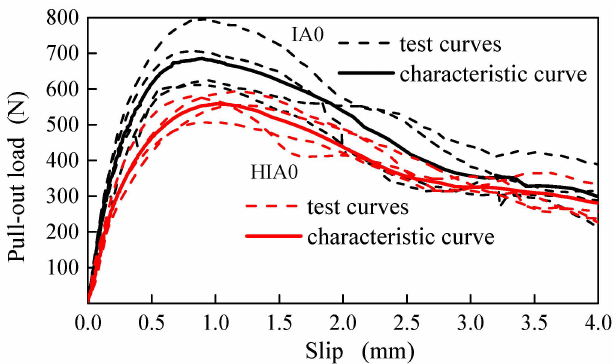
Figure 2. Two characteristic PL-S curves from the test curves of two groups of specimens. Accompanied with each series of specimens, three mortar prisms with dimension of 40 mm × 40 mm × 160 mm were poured for determining its flexural and compressive strengths as per China code GB/T17671 [35]. Due to the difference of casting time and environment, a differential of strength exists in different series of specimens, even though they all have the same composition and test age. The compressive and flexural strengths of mortar used for Series IA, HIA and NA were 75.8 MPa and 11.13 MPa, 69.9 MPa and 8.35 MPa, 77.8 MPa and 12.38 MPa with standard variations of 6.6 MPa and 1.11 MPa, 5.8 MPa and 1.24 MPa, 3.89 MPa and 1.24 MPa,